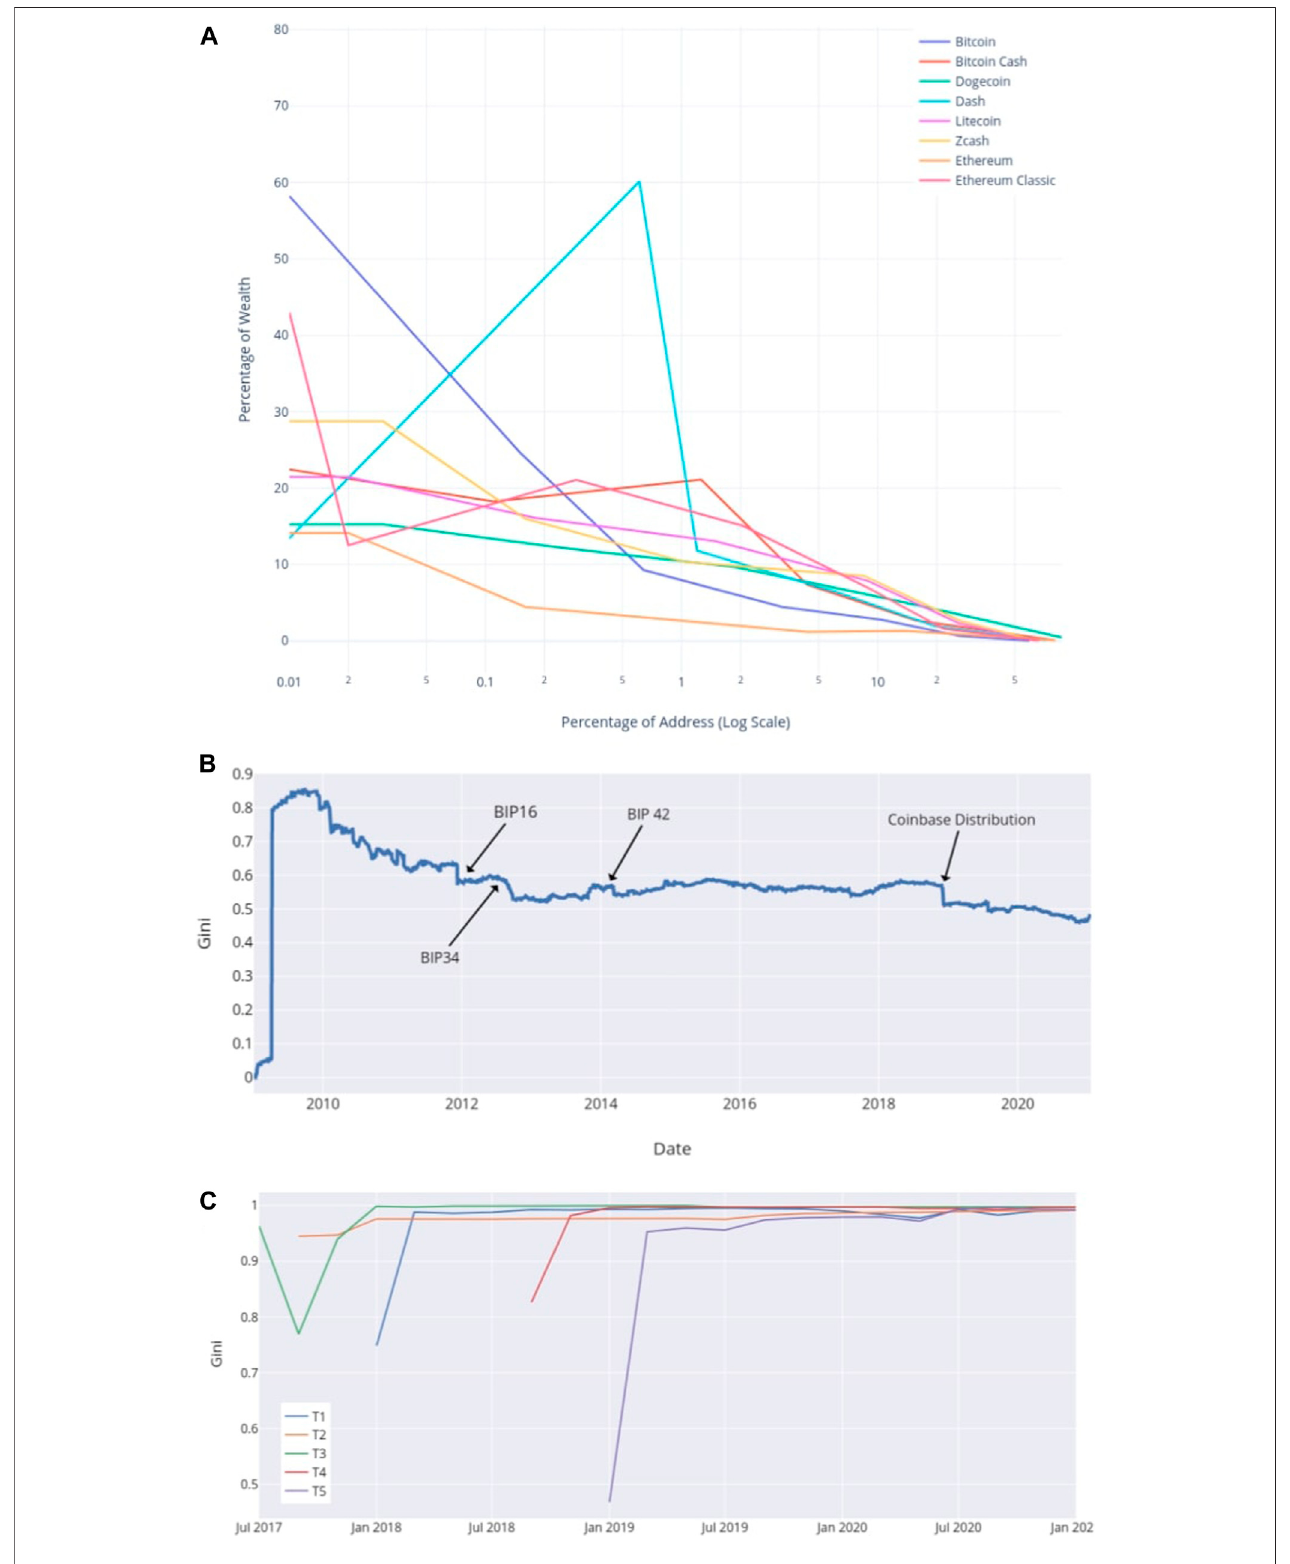
FIGURE 4 | Uni fi ed address-balance (A – B) model.